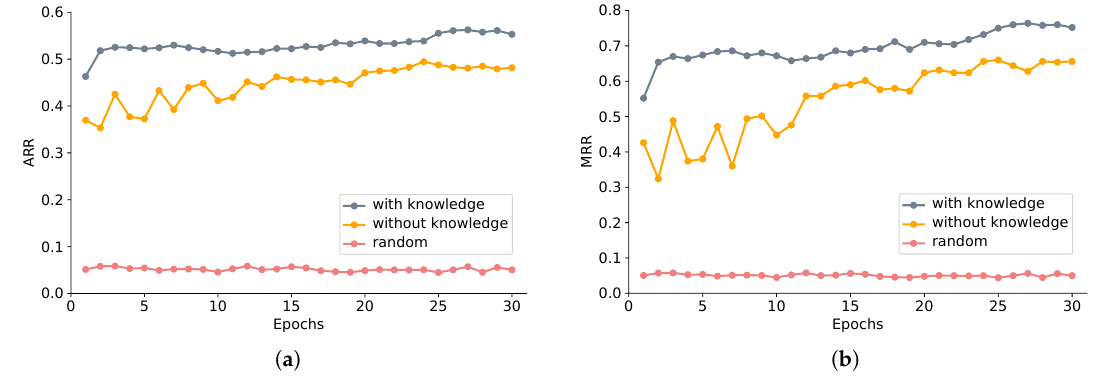
Figure 5. Performance of the random action agent, without-knowledge agent and with-knowledge agent at different epochs. ( a ) performance of the average recall rate (ARR) at different epochs; and ( b ) the middle recall rate (MRR) at different